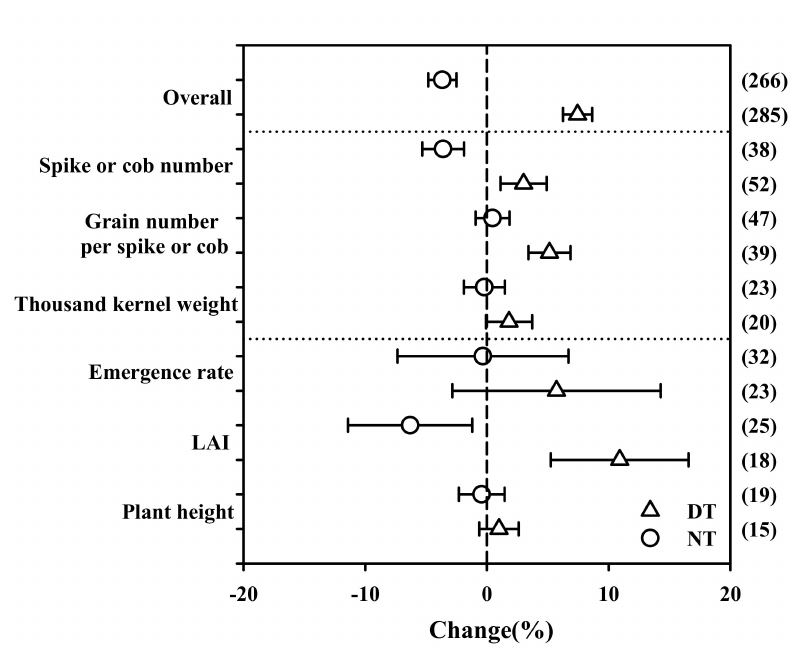
Figure 1. Changes in crop yields and agronomic traits under DT and NT compared to RT management plans. Triangles and circles indicate the effect size of DT and NT, respectively. The number of observations (n) for each category is shown in parentheses. Error bars represent 95% confidence intervals (CIs). Differences are considered significant when the CIs do not include zero. LAI: leaf area index; DT, deep tillage; NT, no tillage; RT, rotary